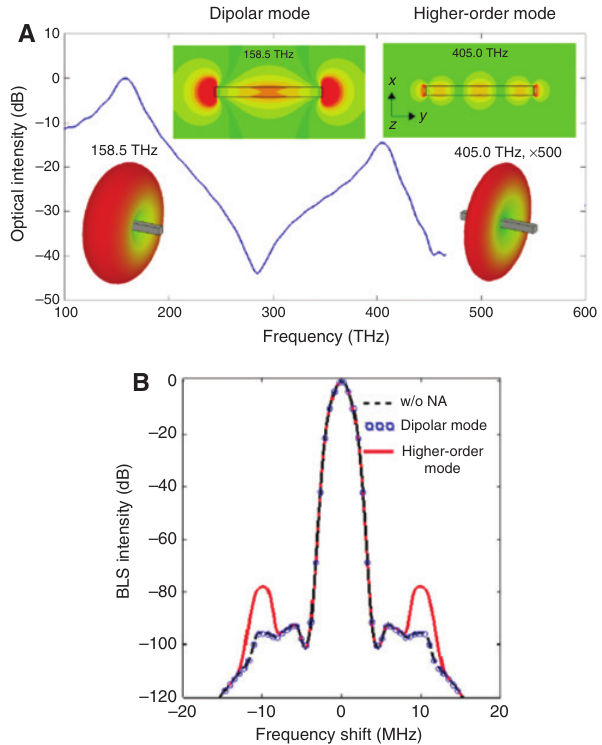
Figure 3: Plasmonic nanoantenna